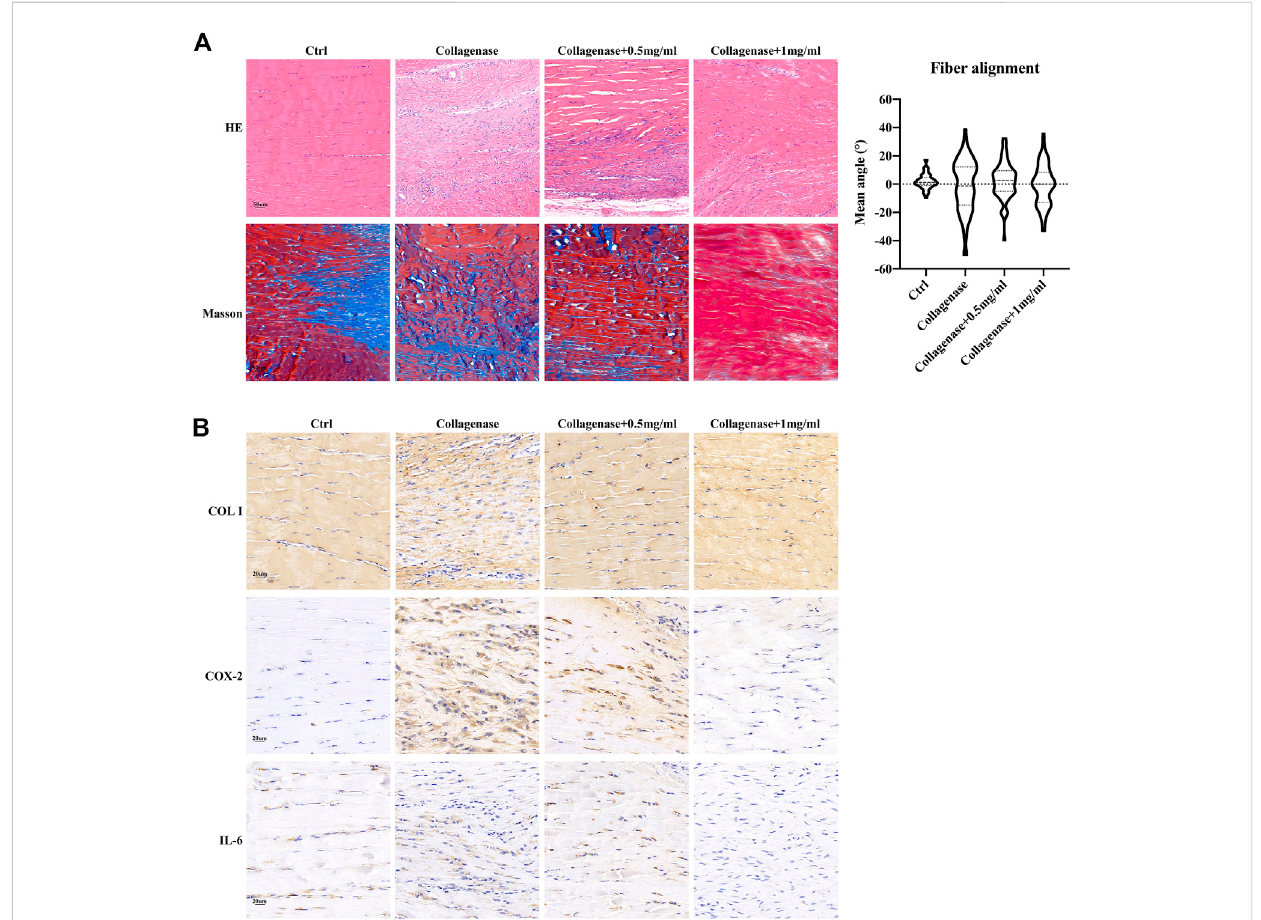
FIGURE 6 Inhibition offullerenol (0.5,1 mg/mL)ontendinopathy invivo . (A) HEandMasson stainingoftendonsinCtrl,Collagenase, Collagenase+0.5 mg/mL, Collagenase+1 mg/mLgroups(Left).Statisticalresultsof fi beralignment(Right).Scalebar=50 μ m. (B) Immunohistochemicalstaining(COLI,COX-2,IL- 6) of tendons in Ctrl, Collagenase, Collagenase+0.5 mg/mL, Collagenase+1 mg/mL groups. Scale bar = 20 μ